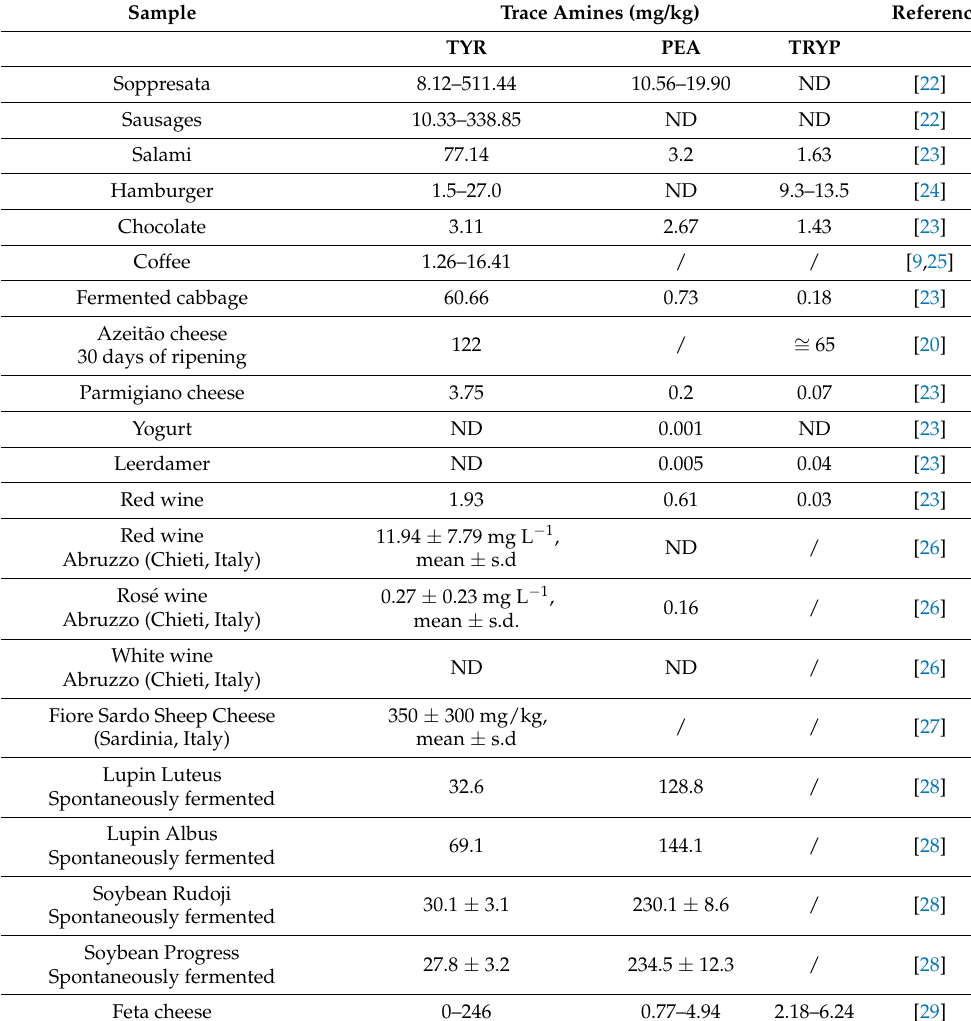
Table 1. Major trace amines tyramine (TYR), β -phenylethylamine (PEA), and tryptamine (TRYP) found in